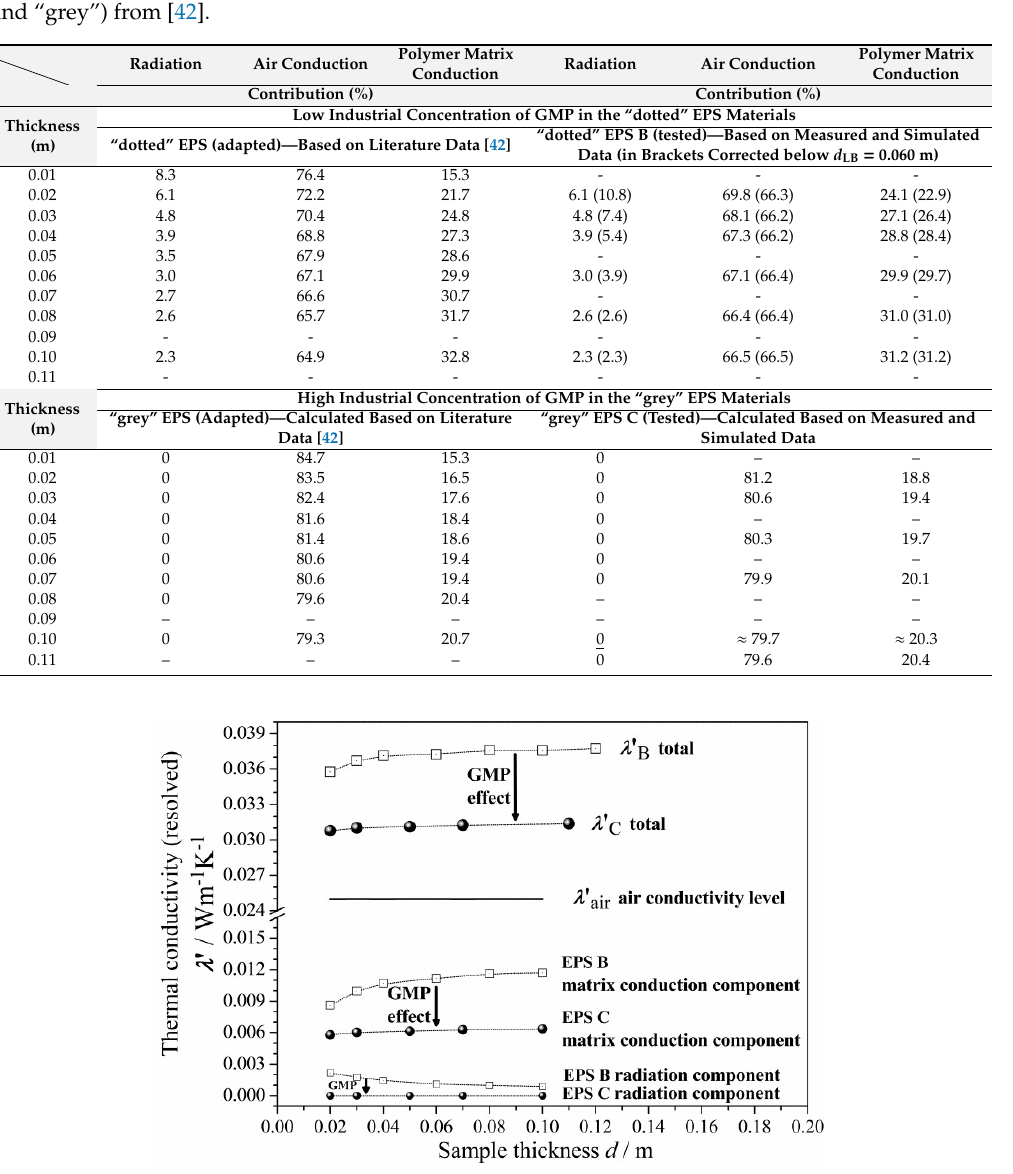
Figure 9. The GMP effect on the total thermal conductivity, resolved into its components. Each component value is calculated by multiplying the contribution fraction (Table 5) by the total thermal conductivity. Notice the impact of GMP on the thickness effect.